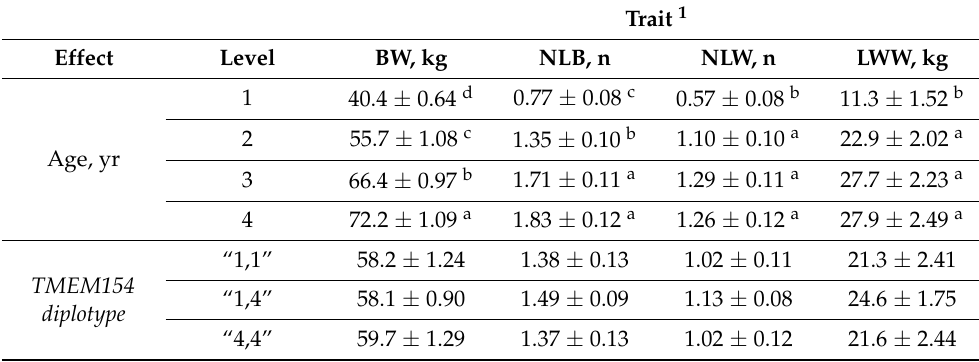
Table 3. Least-squares means ( ± SE) for the main effects of ewe age and TMEM154 diplotype on annual body weight at breeding and reproductive performance in Experimental flock